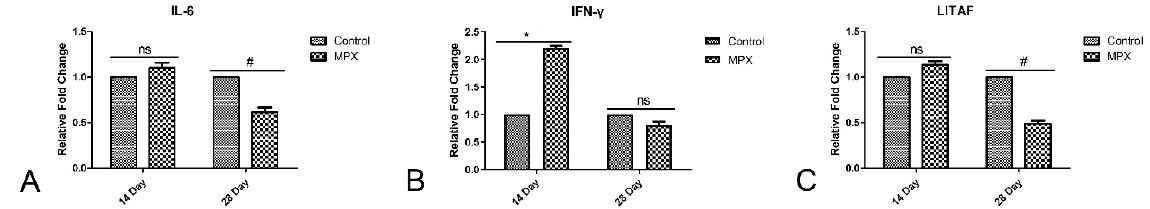
Figure 3. Effects of MPX supplementation on the expression of intestinal immune factors at 14 d and 28 d. ( A ) mRNA expression of IL-6 at 14 d and 28 d after MPX supplementation. ( B ) mRNA expres- sion of IFN- γ at 14 d and 28 d after MPX supplementation. ( C ) mRNA expression of LITAF at 14 d and 28 d after MPX supplementation. ns represents no significant difference between control group and MPX group; # represents significant difference between control group and MPX group at 28 d, p < 0.05; * represents significant difference between control group and MPX group at 14 d, p < 0.05.